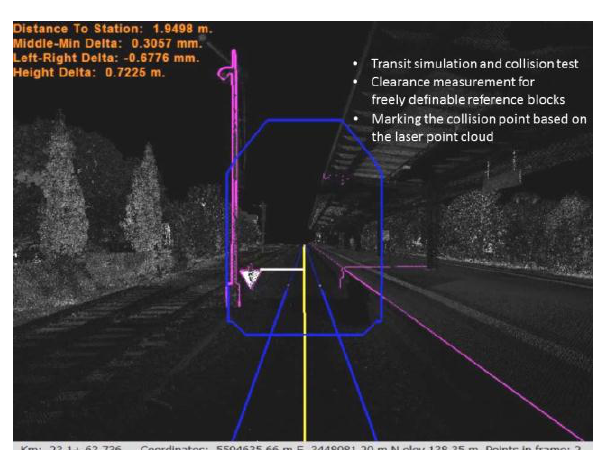
Figure 13: Automatic check of the clearance with SiRailScan For the Deutsche Bahn AG, the results of the clearance Figure 10: Standard clearance profile “G2” measurements have to be documented in a specific format (“LUE”). In addition to the clearance measurements, supplemental information like camera images or point cloud screenshots can be saved with the data. This extended dataset (“LIE”) can be imported into the clearance database and evaluated with the software WinLUE . In Figure 14 and Figure 15 an example of a clearance narrow point detected with RailMapper near Weilburg/Lahn in Germany can be